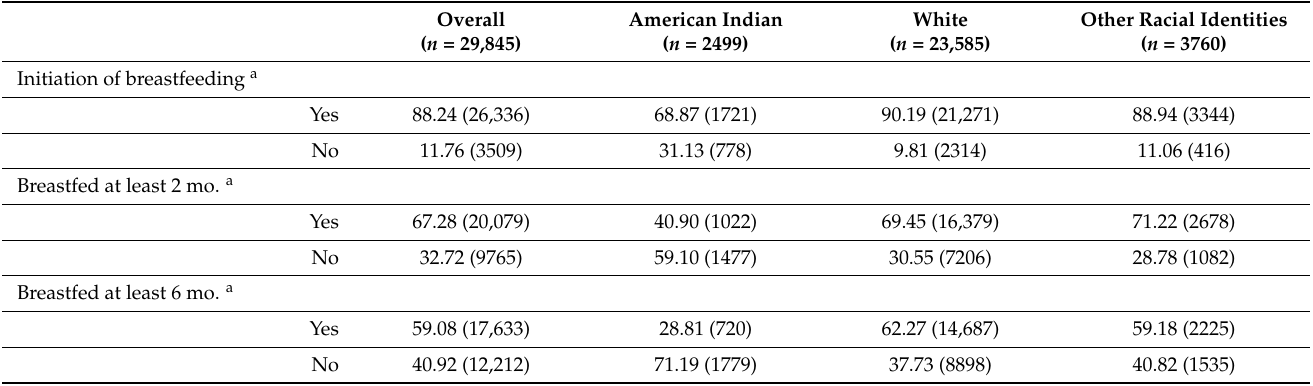
Table 1. Weighted Percent (and frequency) of breastfeeding outcomes and covariates, overall and by race/ethnicity in ND PRAMS (2017–2019)